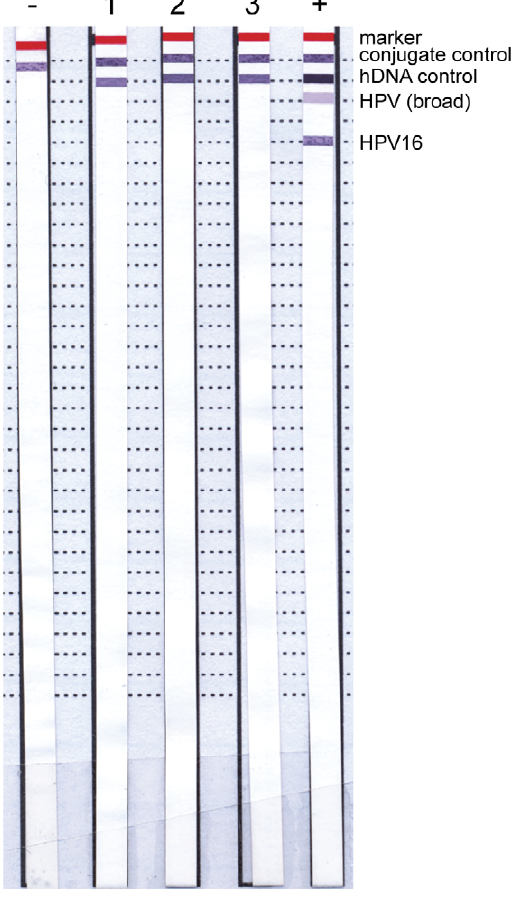
Figure 5. Detection of HPV in prostate cancer tissue DNA. HPV DNA in PC tissue DNA samples was detected using INNO-LiPA HPV Genotyping Extra. HPV DNA was amplified from samples using primers to conserved sequences generating biotinylated products. Biotinylated amplicons were then hybridised to strips bearing conserved and type- specific HPV probes. Bands indicate binding of the biotinylated sample DNA to the target indicated. Marker is for aligning strips, conjugate control confirms the kit reagents are functioning correctly, hDNA control indicates the presence of human DNA in the sample, HPV (broad) indicates binding of HPV DNA to probes that bind conserved regions. All other dotted lines show areas bound by specific HPVs e.g. HPV16 (shown). Numbers above strips are patient designations (only 3 sample strips are shown for clarity), 2 , negative control (water), + , positive control (supplied with kit). Result for the single HPV positive is not shown as it was too faint to appear on a scanned image. doi:10.1371/journal.pone.0034221.g005 phylogenies were predicted using the general time reversible model of nucleotide substitution and a gamma-distributed rate heterogeneity using the program MrBayes [30]. The MCMC algorithm was run for 4,000,000 generations, sampling trees every 100 generations. ESS values were calculated using Tracer (http://beast.bio.ed.ac.uk/Tracer). The consensus tree with branch lengths and posterior probability support values for the internal nodes was visualised in FigTree (http://tree.bio.ed.ac. uk/software/figtree), rooting on MoMLV as an outgroup and edited using Adobe Illustrator.